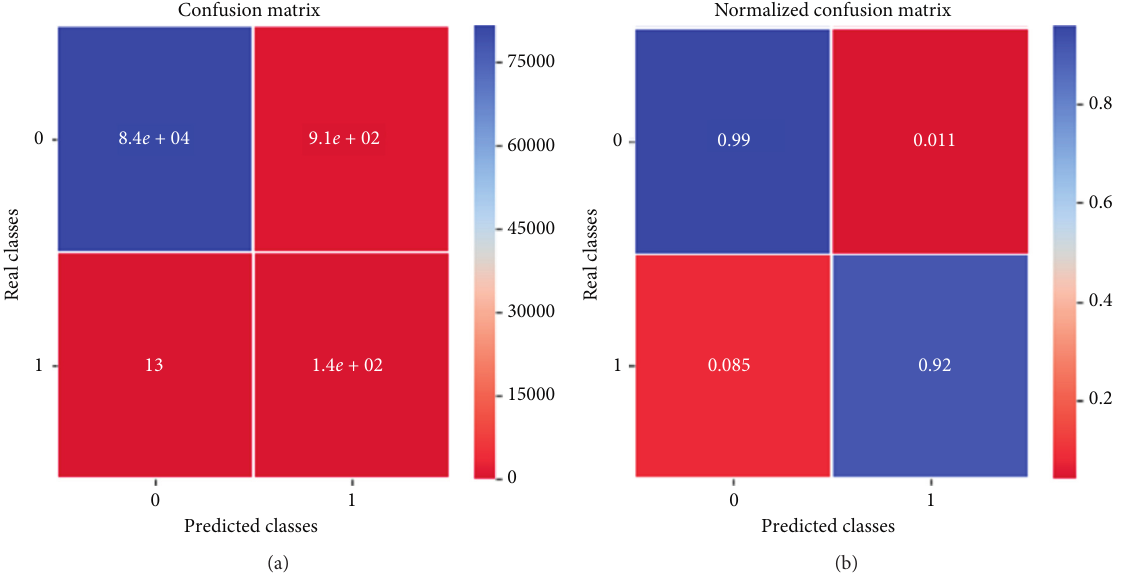
Figure 10: (a) Confusion matrix and (b) normalized confusion matrix for SMOTE